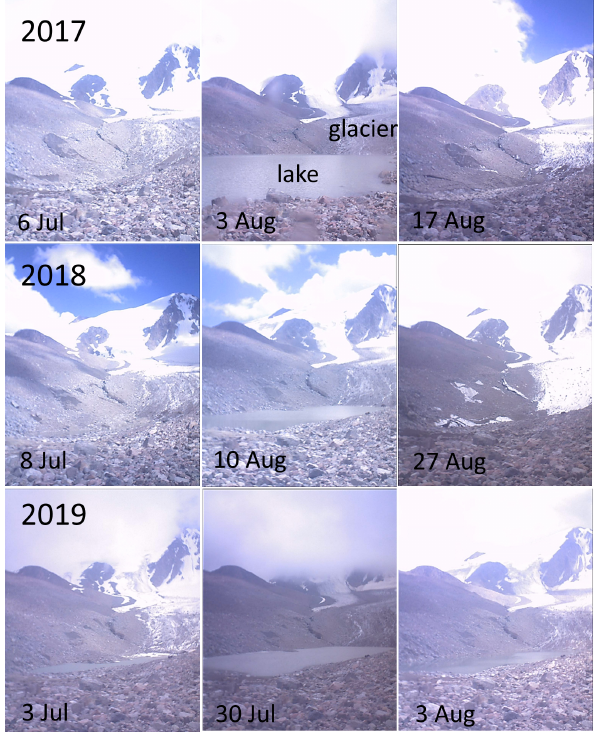
Figure 5. Korumdu lake during 2017–2019 from on-site on time- lapse camera images acquired in the